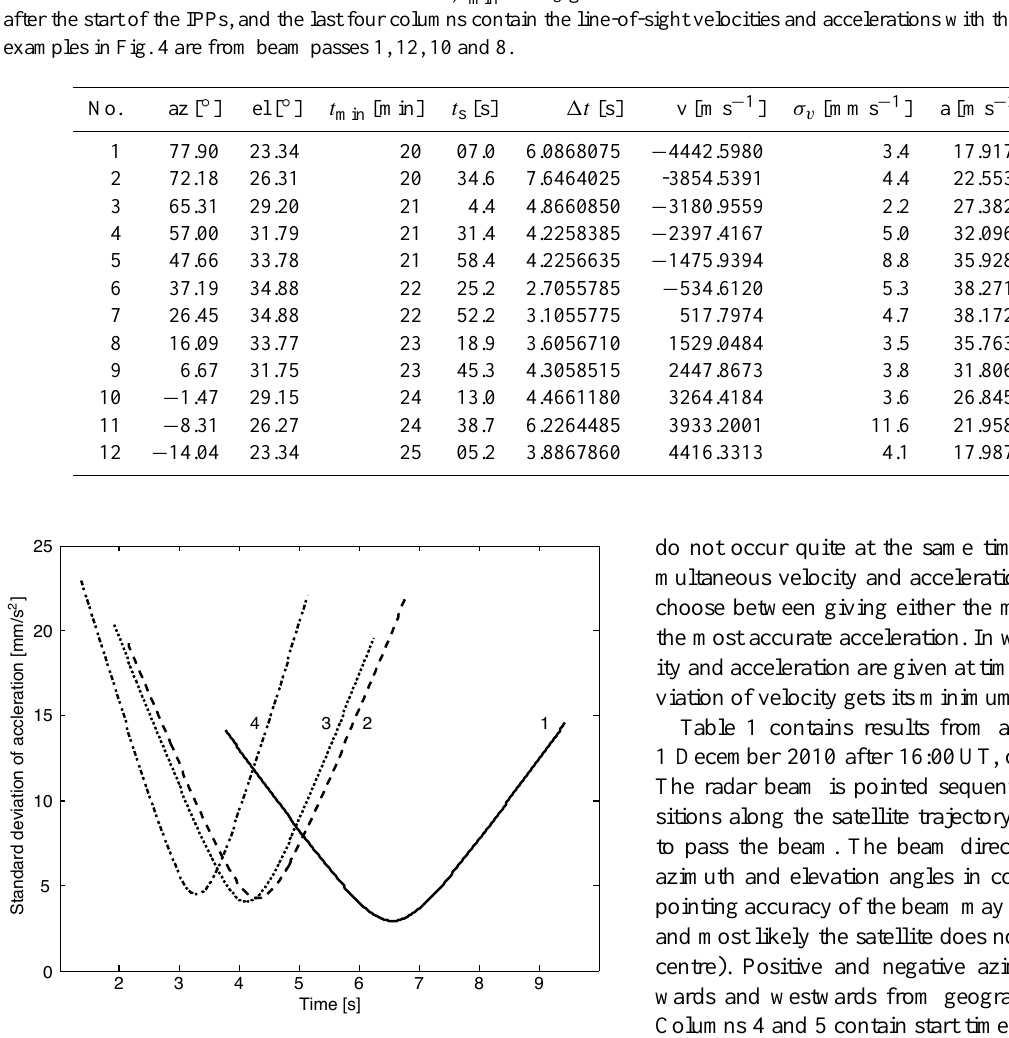
Fig. 7. Standard deviations of fitted accelerations from the four beam passes. Numbers on the curves refer to the panels in Fig.